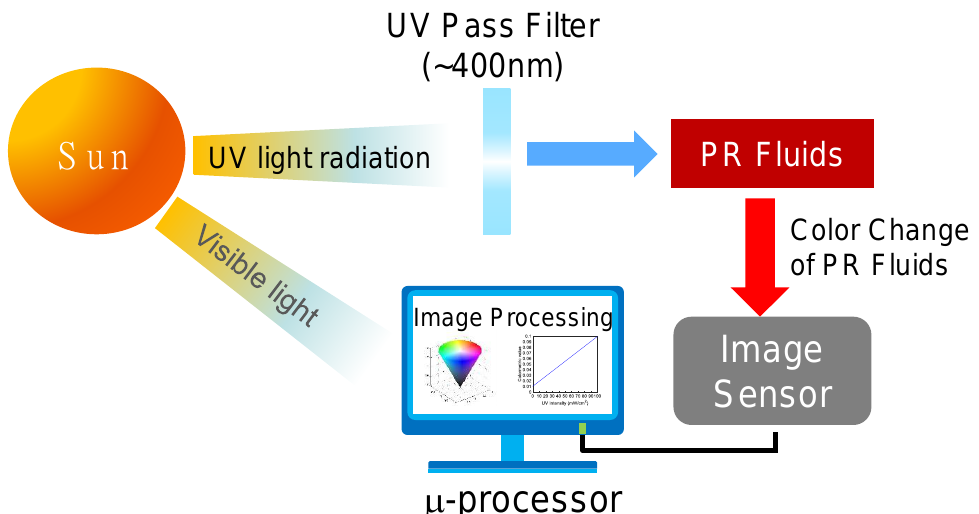
Figure 2. Measurement principle of colorimetric UV intensity sensor.